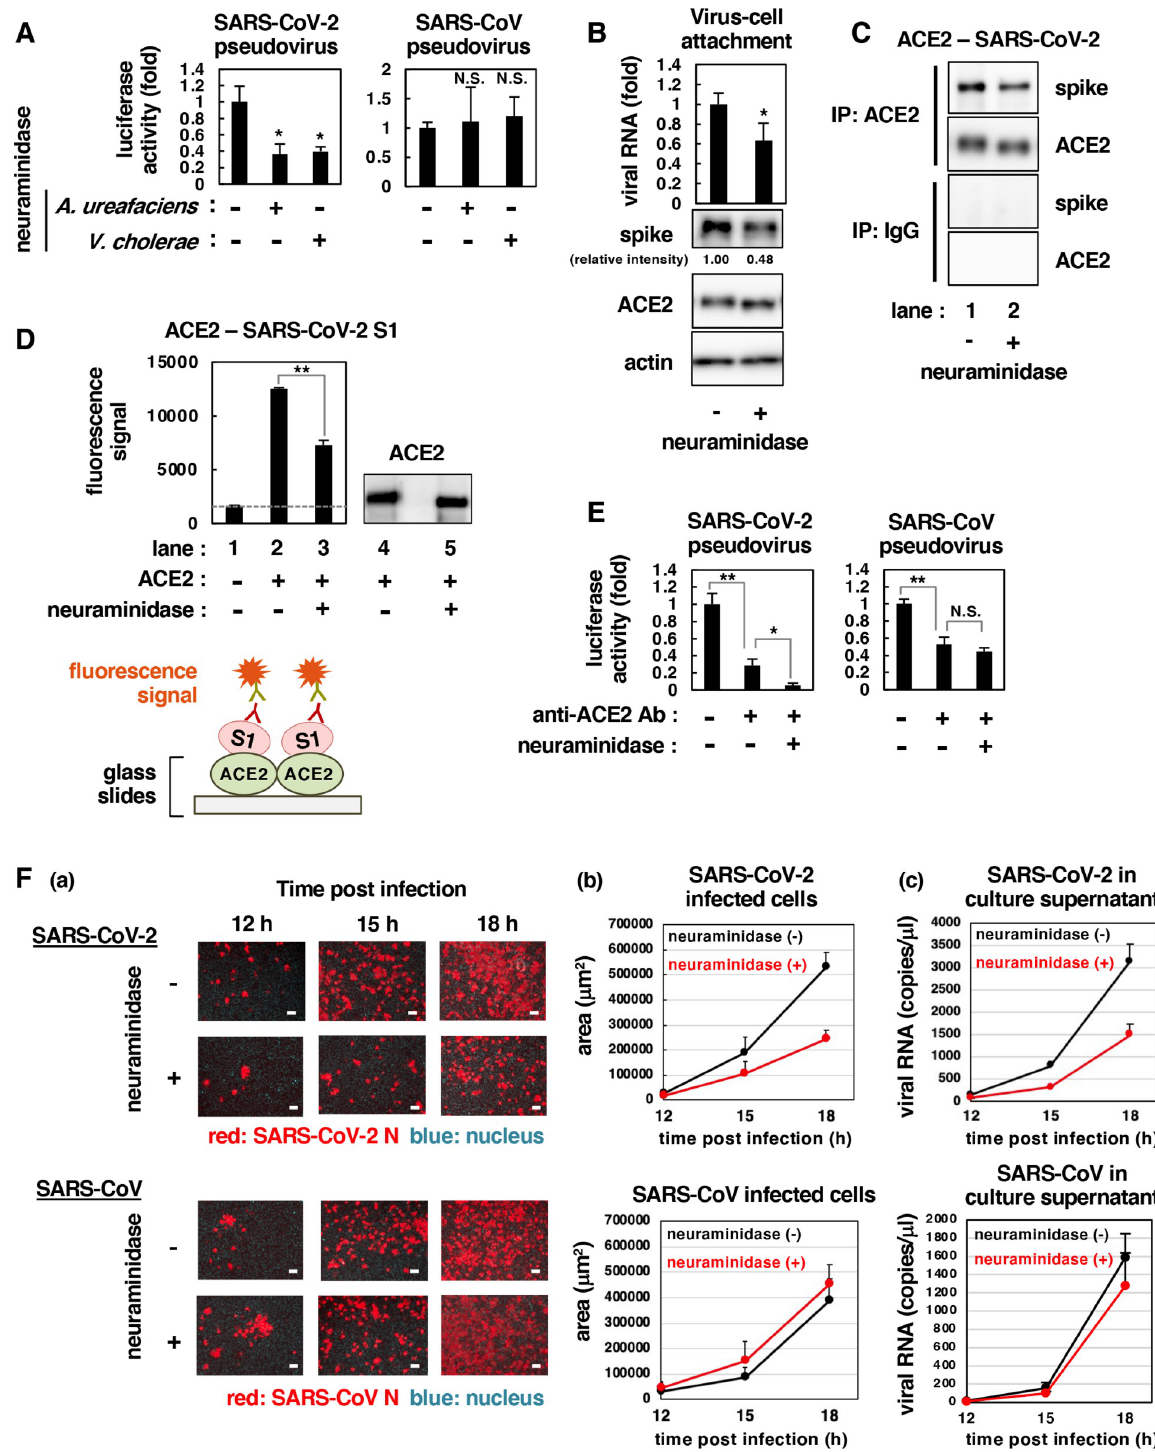
Fig 5. Host sialic acid contributed to the efficient spread of SARS-CoV-2 infection. (A) SARS-CoV-2 or SARS-CoV pseudovirus infection to neuraminidase-treated cells. VeroE6/TMPRSS2 cells were pretreated with or without indicated neuraminidases for 2 h at 37˚C, followed by inoculation with SARS-CoV-2 or SARS-CoV pseudovirus. At 24 h post-inoculation, cells were lysed and luciferase activity was quantified. (B) SARS-CoV-2 attachment on neuraminidase-treated cells. VeroE6/TMPRSS2 cells were treated with or without neuraminidase for 2 h at 37˚C, then the cells were inoculated with SARS-CoV-2 for 1 h at 4˚C. After washing unbound viruses, the cells were lysed and attached viral RNA was